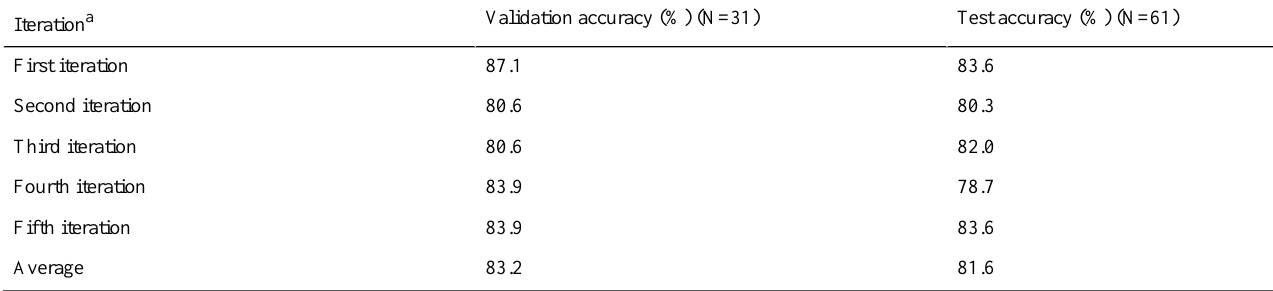
Table 3. Results for five-fold cross-validation.